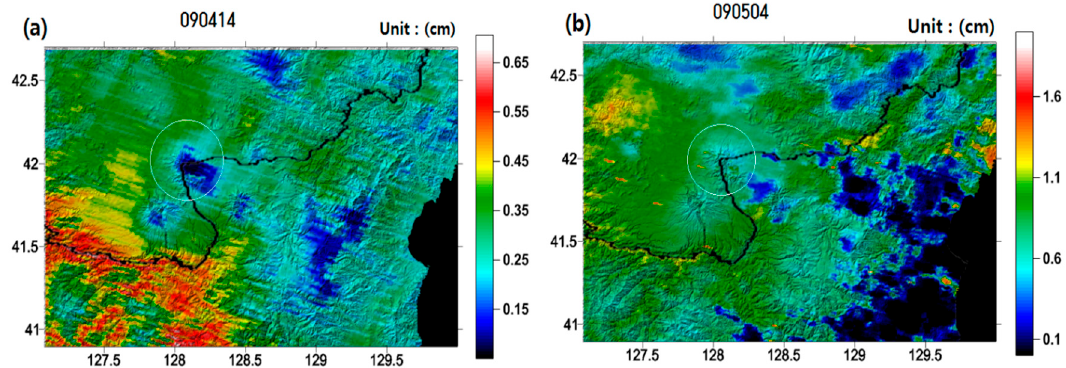
Figure 2. Water vapor anomaly around Mt. Baekdu (outlined by the white circle) shown in MODIS MOD 5 water vapor products on ( a ) 14th of April 2009 ( b ) 5th of May 2009.